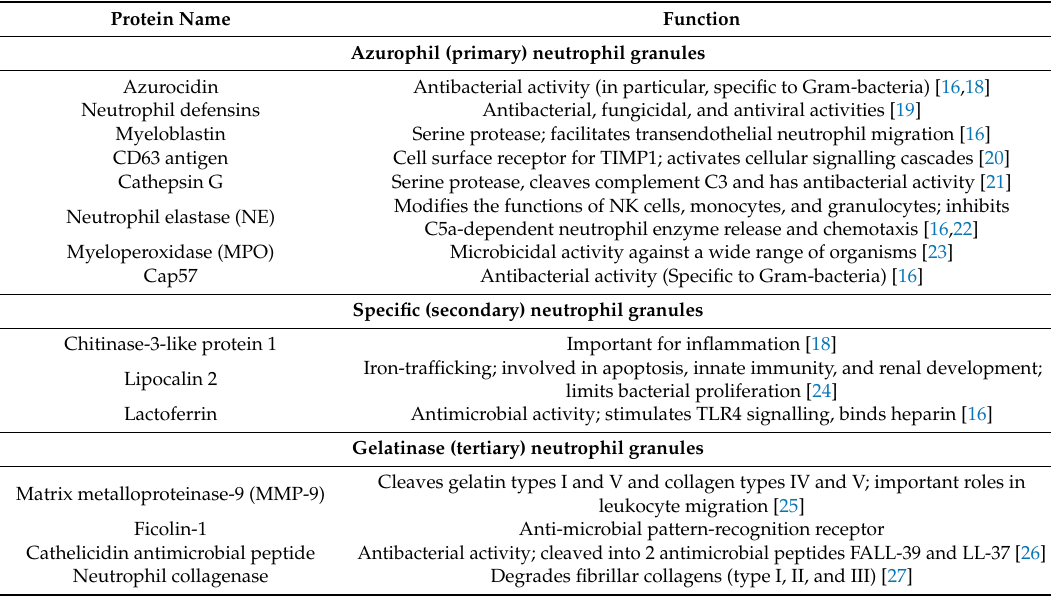
Table 1. Neutrophil granules and their anti-microbial